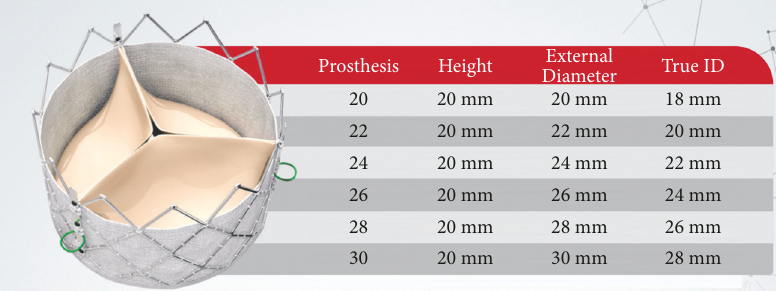
Figure 4: Chart of Inovare ® Alpha sizes.